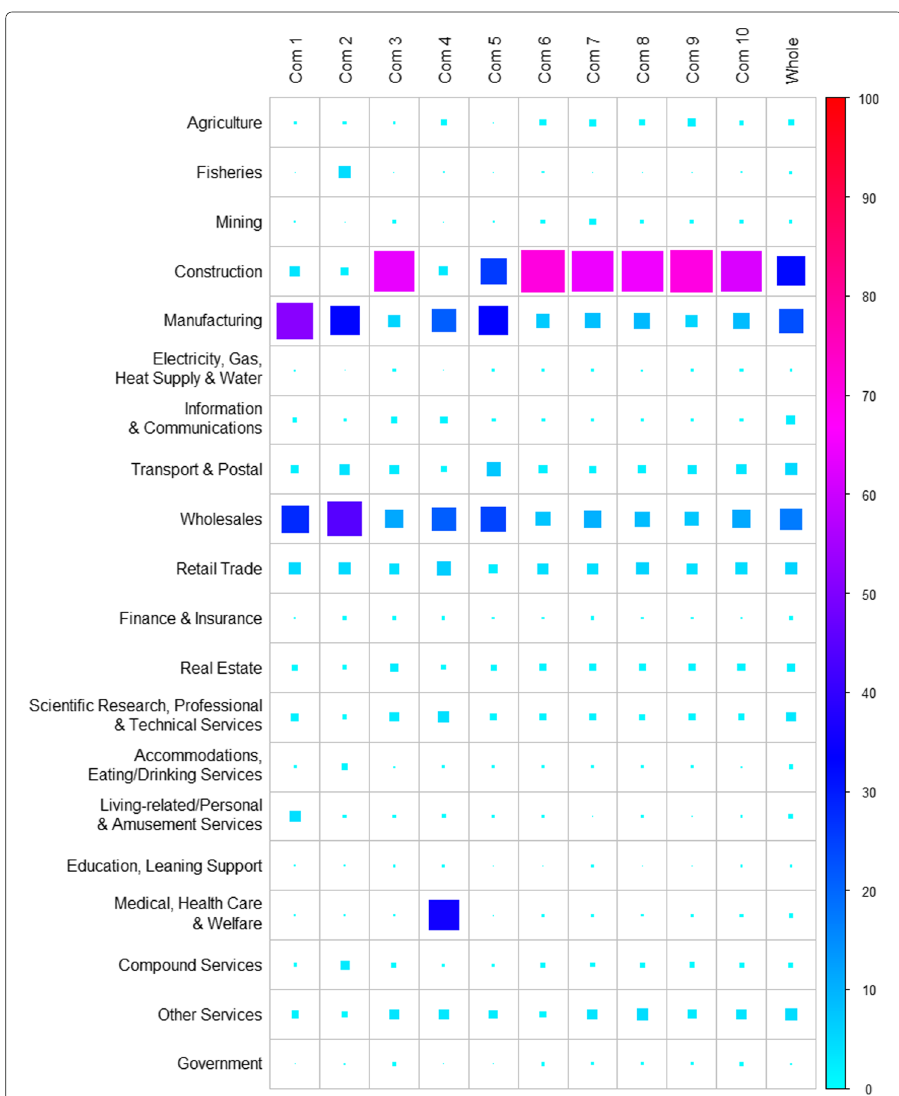
Fig. 13 Industrial characterization of the 10 largest communities obtained for the circular flow network on the GSCC by share of sectors to which their constituent firms belong. The size of each square is proportional to share of the corresponding industry in the specified community. Additionally, its share value (in percentage) is represented by the color